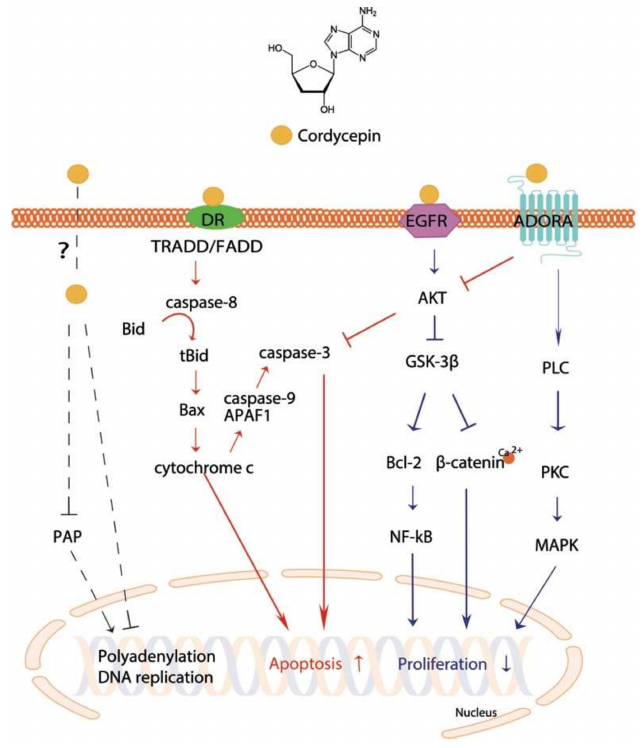
Figure 1. Cellular apoptotic and proliferative pathways stimulated by cordycepin. Arrows and bar-headed lines represent signaling activation and inhibition, respectively. Red- and blue-colored arrows indicate the processes involved in cell apoptosis and proliferation, respectively. Black dotted lines show processes involved in DNA and/or RNA polymerases activity.